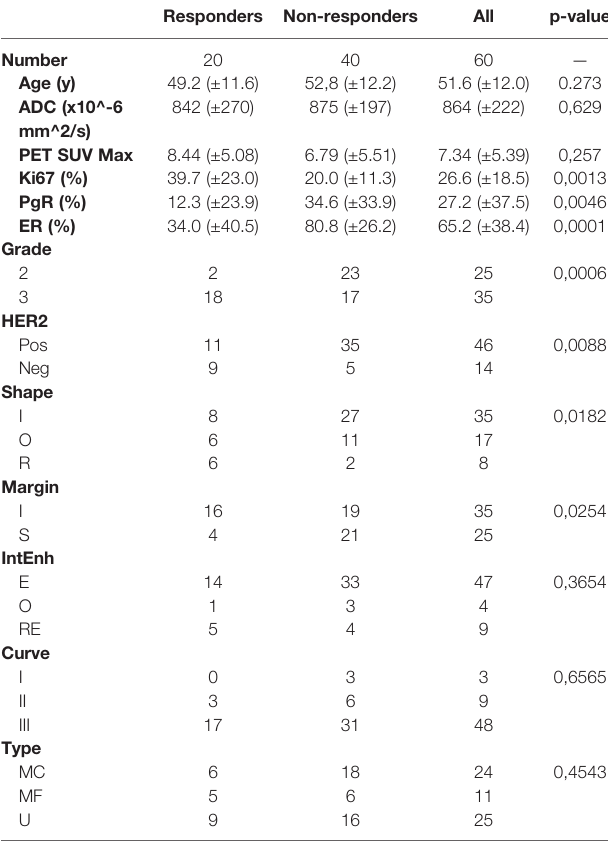
TABLE 1 | Clinical, histological and radiological characteristics of the patients as a function of pathologic response. Responders Non-responders All